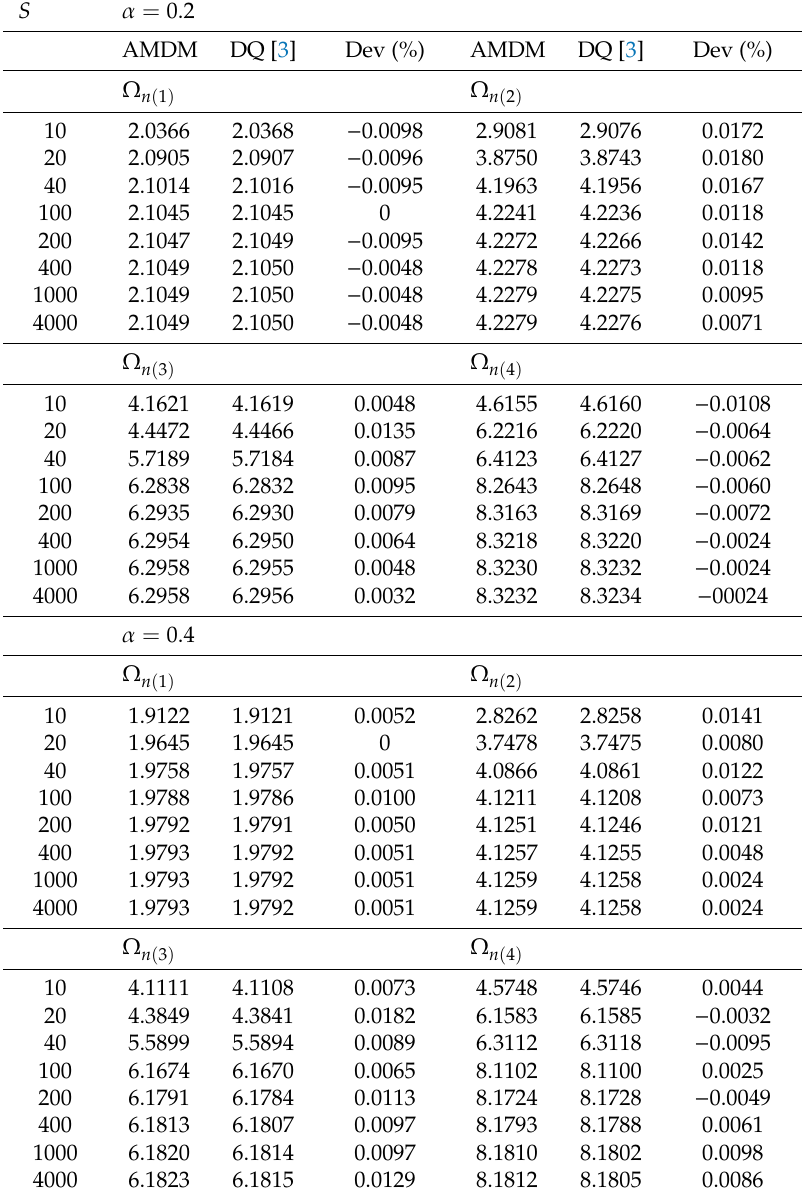
Table 3. The first four nondimensional natural frequencies ( Ω n ( i ) ) for a nonrotating arch ( θ 0 = 90 ◦ ) (cid:16) (cid:17) (cid:112) R θ 0 / I 0 / A 0 against the slender ratio S = and under simple-free boundary conditions. S α =